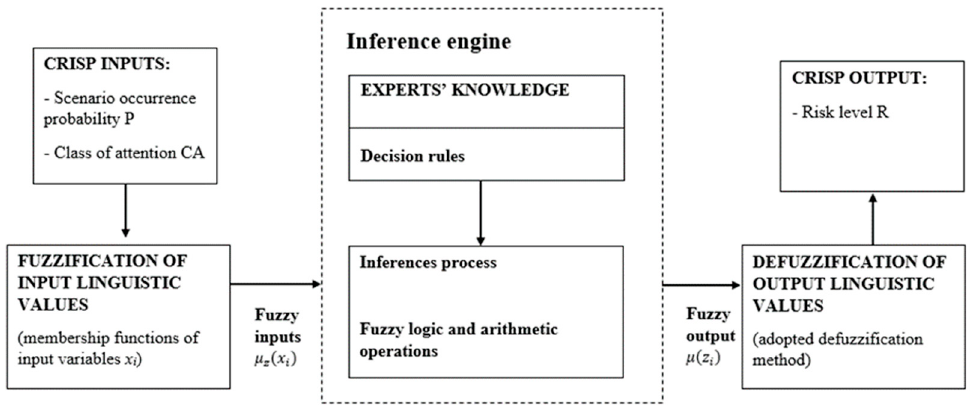
Figure 5. The structure of a typical fuzzy logic system (FLS) [39,48,57].